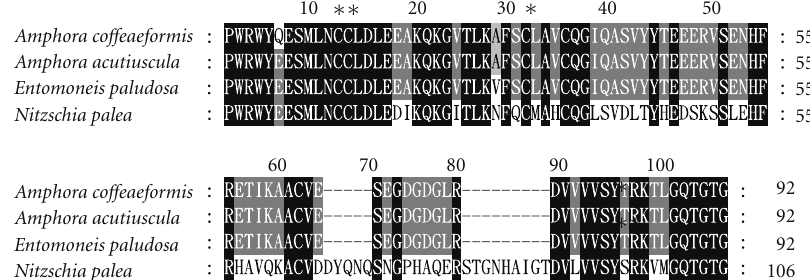
Figure 7: Alignment of the amino acid sequences of phytochelatin synthase fragments isolated from Amphora acutiuscula (FN995989), Amphora co ff eaeformis (FN995985), Entomoneis paludosa (FN995987) and Nitzschia palea (FN995985) grown in ASW. Black boxes indicated 100% identity, dark grey 80%, and light grey 60%. The cysteine residues are indicated by